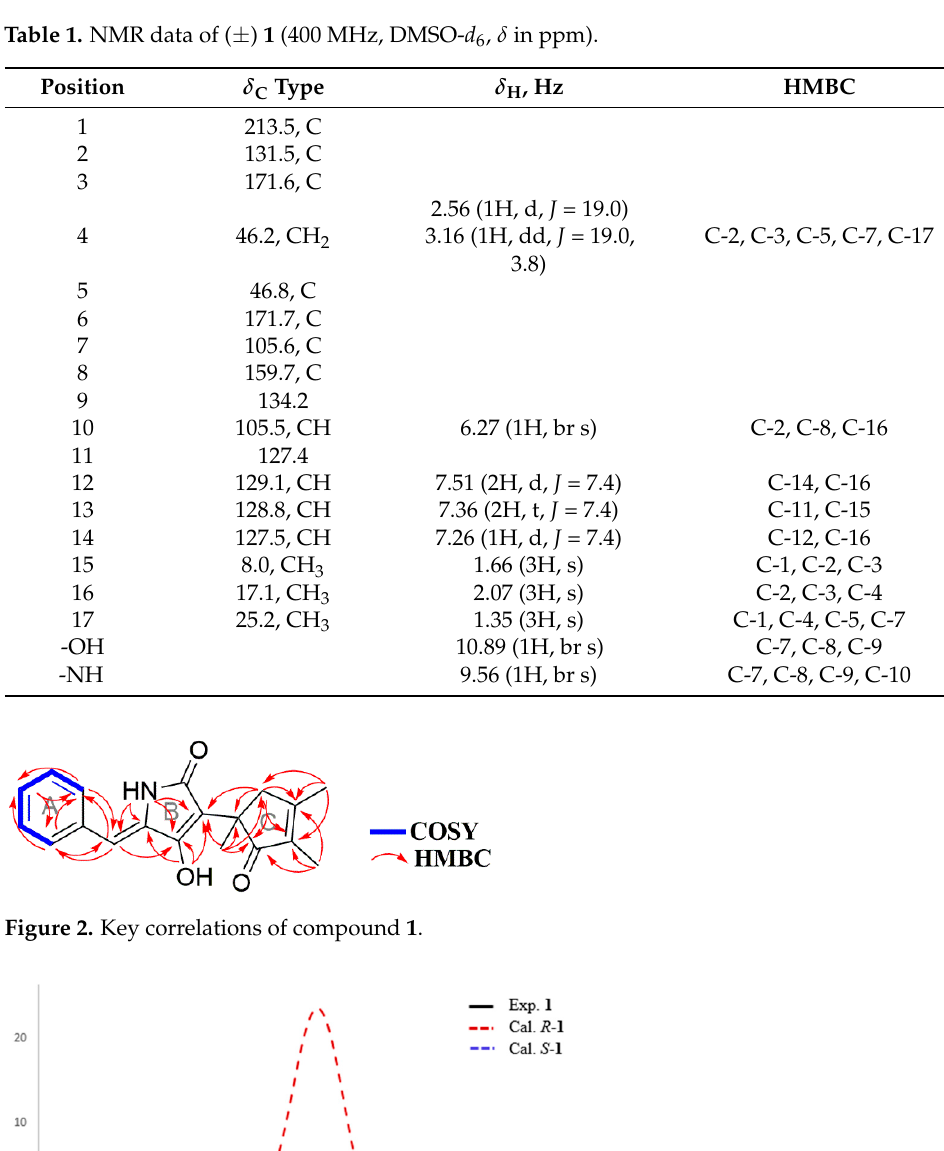
Table 1. NMR data of ( ± ) 1 (400 MHz, DMSO- d 6 , δ in ppm).